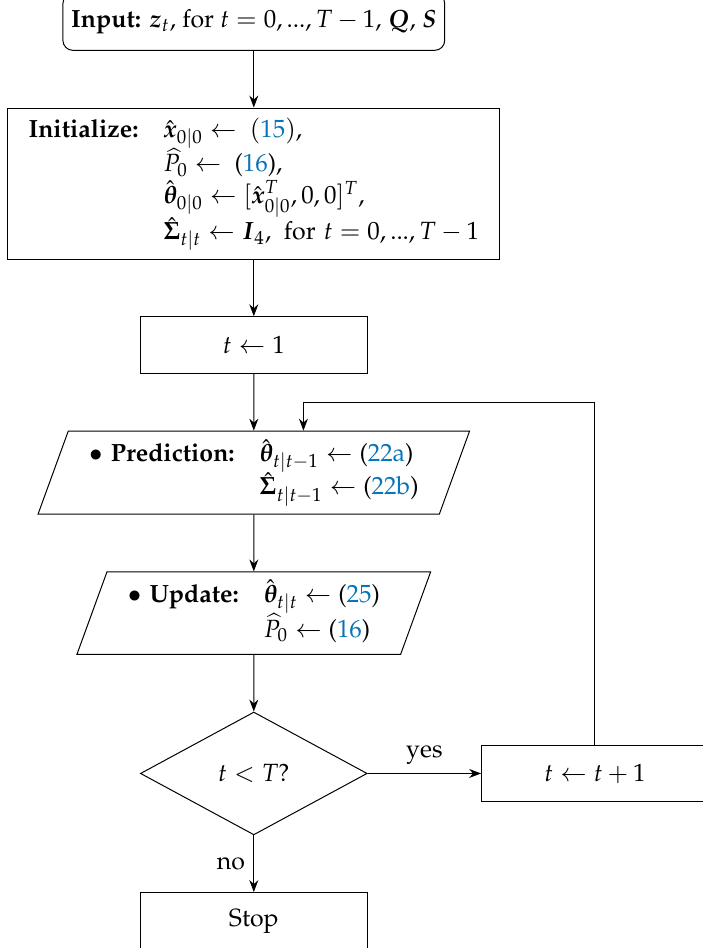
Figure 1. Flowchart of the proposed uMAP